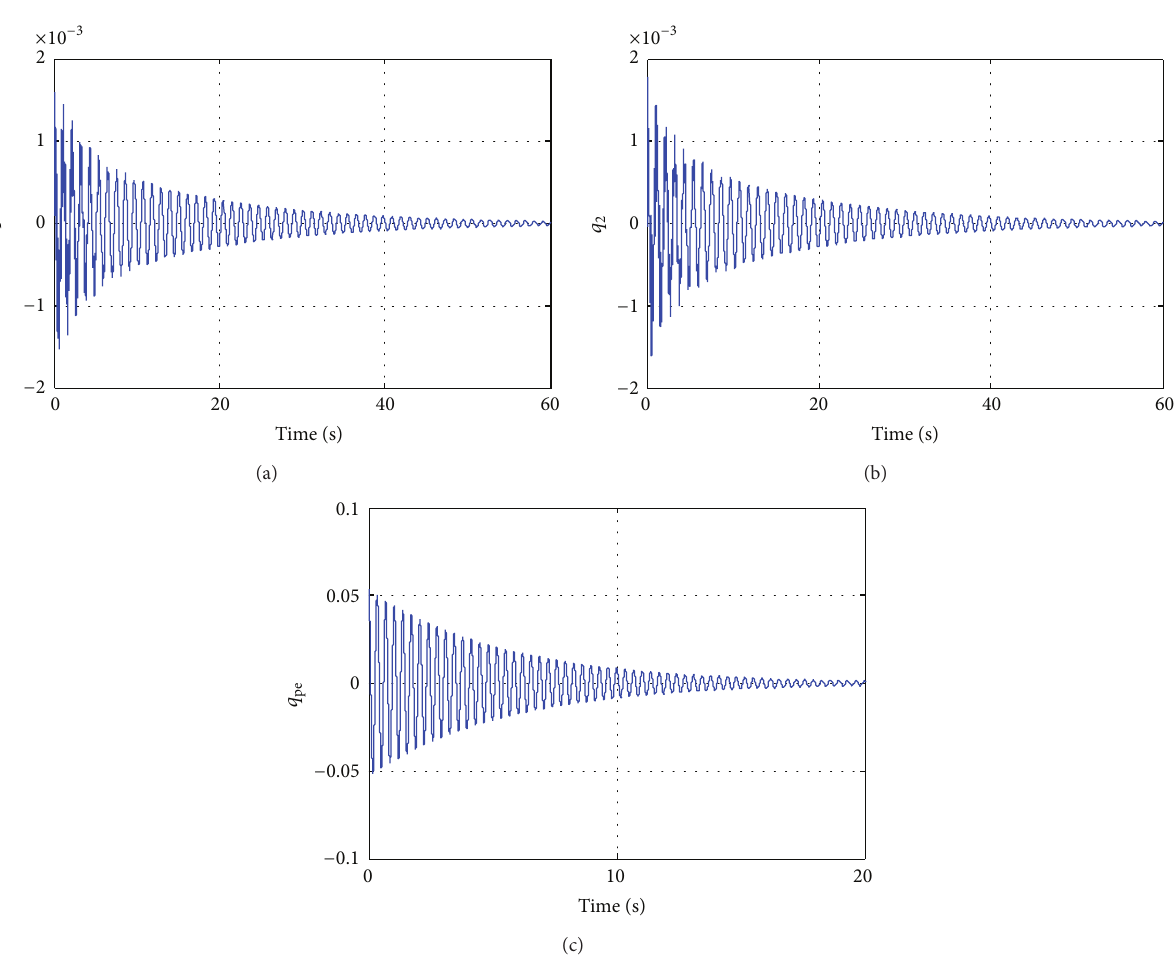
Figure 7: Feedback linearisation with cancellation of nonlinearity only and with eigenvector assignment: response at 80 ms −1 (assumed- modes